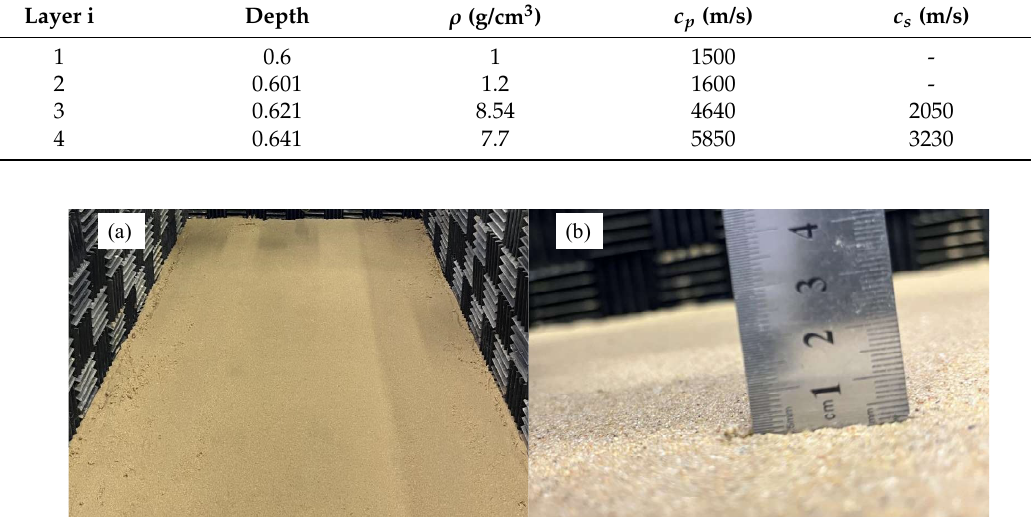
Figure 9. ( a ) The silt sediment layer in the water tank experiment. ( b ) Silt sediment with a thickness of 1